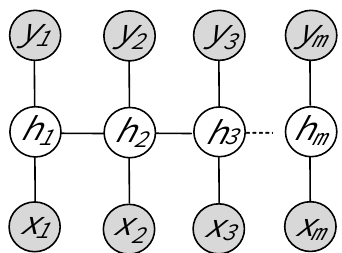
Figure 6. Graphical representation of the Latent-Dynamic Conditional Random Fields (LDCRFs) model. x j represents the j-th observation, h j denotes the hidden state assigned to x j , and y j is the class label of x j . The nodes in gray circles represent the observed